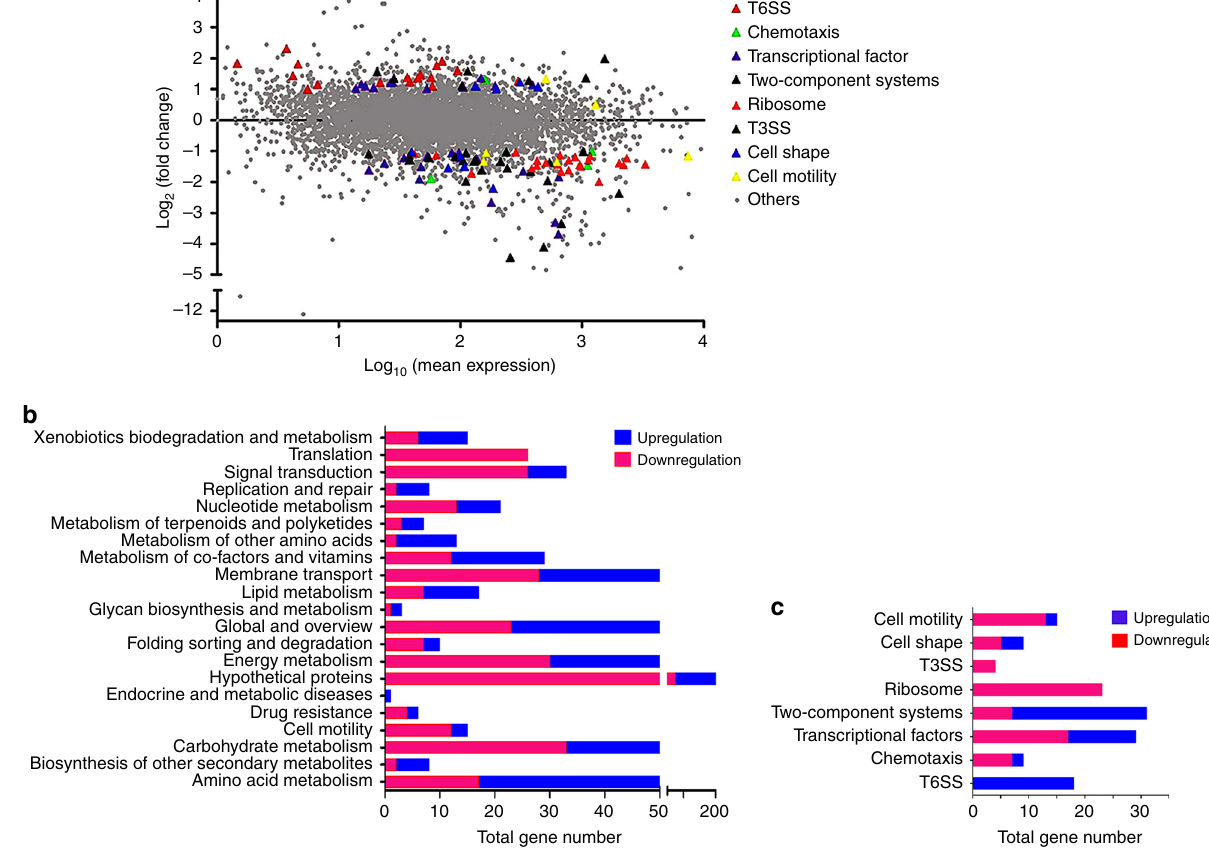
Fig. 4 Transcriptome analysis of strains 1 – 9 and PAK-AR2. a X -axis represents the logarithm-transformed value of gene expression levels. Y -axis represents log2-transformed value of expression change folds. Genes belonging to different pathways are represented by various colored shapes as indicated. Others represent genes not belonging to the indicated pathways. b Expression pro fi les of the genes belonging to the cellular processes in KEGG_B_class. c Expression pro fi les of the genes belonging to the indicated metabolic pathways. Red color shows the genes with signi fi cantly reduced transcription levels. Blue color shows the genes with signi fi cantly elevated transcription